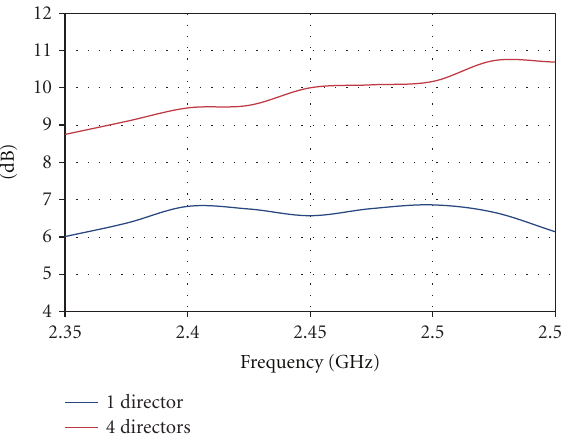
Figure 14: Measured radiation results (realized gain) versus frequency (red: antenna with 4 directors, blue: antenna with 1 director).